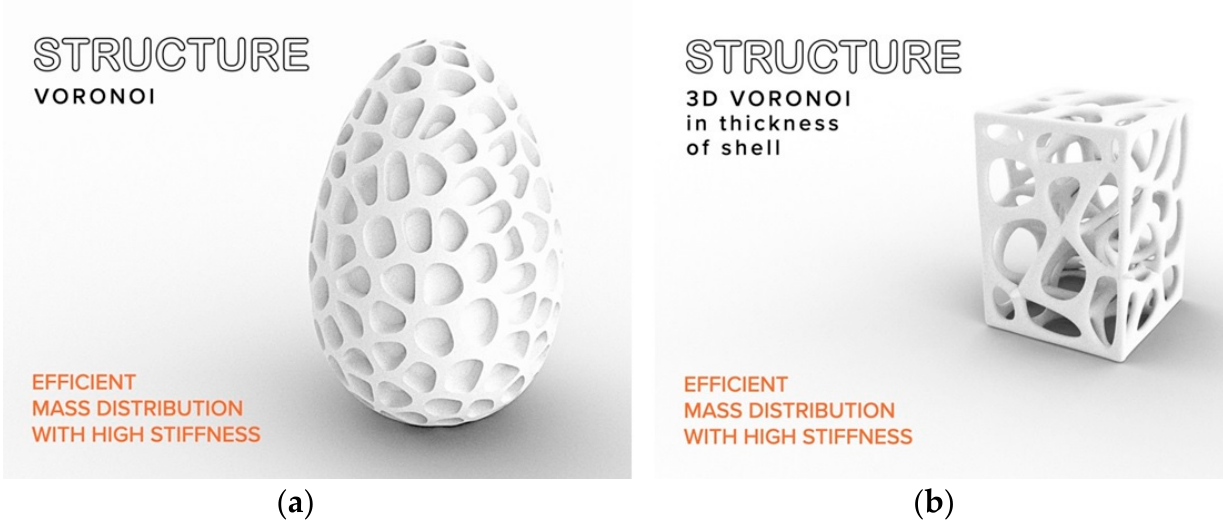
( b ) Figure 5. Schematic representation of the use of a Voronoi structure in cross-section view: ( a ) single- layer Voronoi structure with a partition wall, ( b ) 3D Voronoi structure with regolith infill. Another solution is to apply a 3D Voronoi structure in the wall thickness of the object (see Figure 4b). This creates a complex network system (Figure 5b) which can also be used extensively (but requires more computing power to generate the model). The fundamen- tal difference in comparison to the previous variant is the possibility of directly filling its structure with regolith. For the future full scale design of the lattice cell structure, the principle of finite ele- ment analysis (FEA) should be used to read the properties of that design. FEA for a single- layer Voronoi structure on an egg-shaped surface, and a cut-out of the 3D Voronoi struc- ture, can be used for the entire outer wall thickness envelope. The methodology proposed by Tahseen A. Alwattar and Ahsan Mian [28,29] , based on the principle of equivalent lat- tice cell structure idea to solve the problem, should be very useful. 3. Materials and Methods 3.1. Materials Because of transportation issues between the Earth and the Moon, building Lunar habitats should be solely based on an in situ resource utilization (ISRU) approach. Thanks to the Apollo missions, the composition of Lunar regolith is fairly well known. The fifth and last lunar mission (Apollo 17) brought back 111 kg of lunar soil [30]. On Earth, on the basis of samples brought from the Moon, materials called lunar simulants (imitating the properties of lunar regolith) were created [12]. This enables an understanding of the